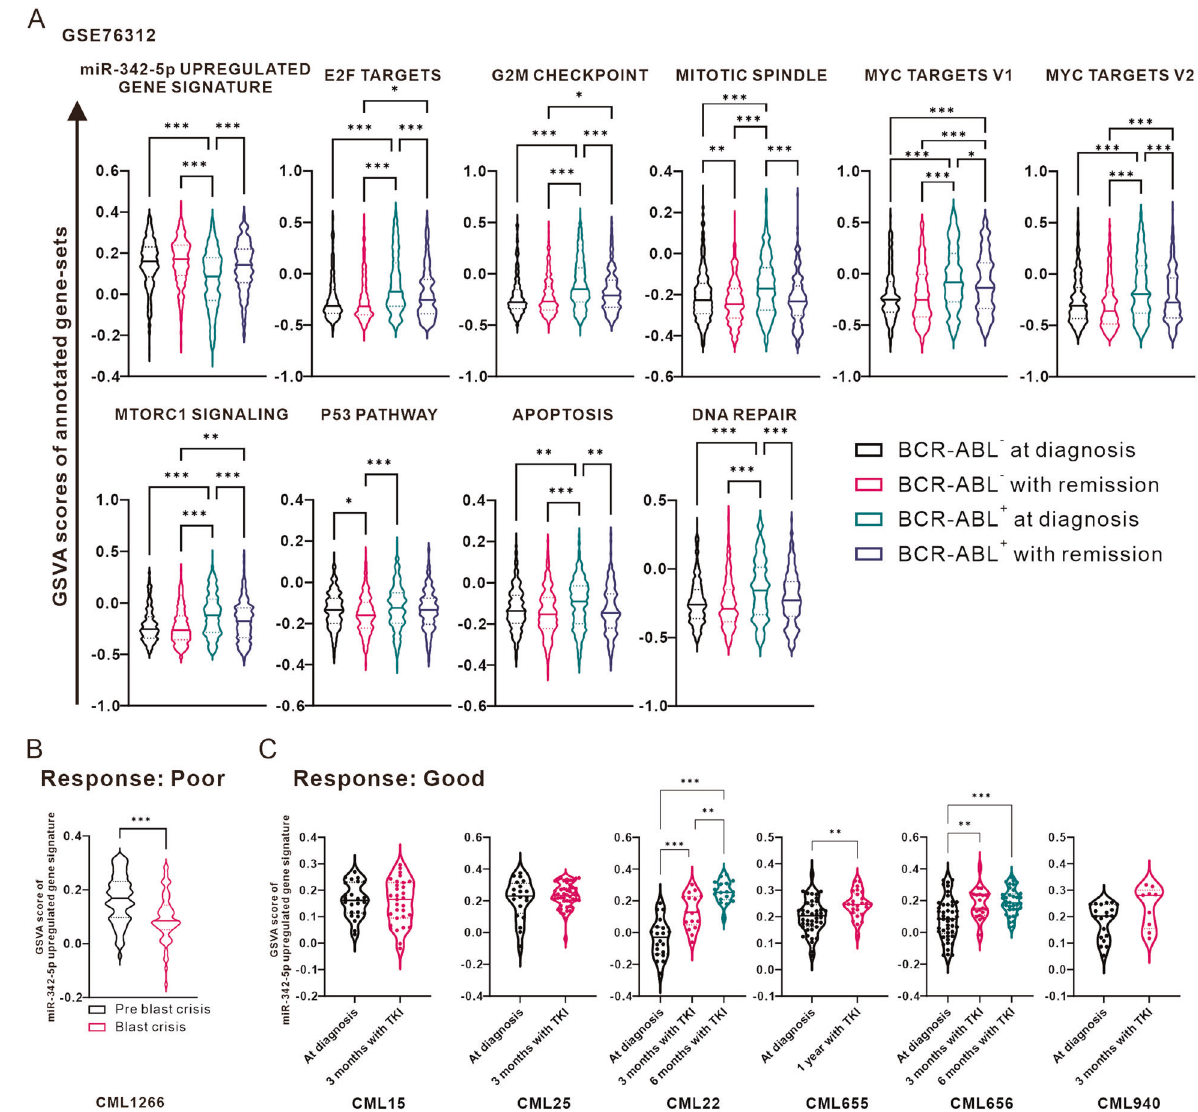
Fig. 8 Investigation of GSVA scores of miR-342-5p upregulated-gene signature of single cells from same CML patients with or without remission in GSE76312. A The Violin plot shows the distribution of GSVA scores of miR-342-5p upregulated-gene signature, cell proliferation- related biological responses, DNA repair, and apoptosis in the single CML cells with or without BCR-ABL expression at diagnostic or remission states in GSE76312. B , C GSVA scores of miR-342-5p upregulated-gene signature of single cells from same CML patients with or without remission (Good or Poor). Data were in the form of mean ± SD. One-way ANOVA or Mann-Whitney test were used to assess the signi fi cance of statistical differences, respectively. * P < 0.05, ** P < 0.01, *** P <